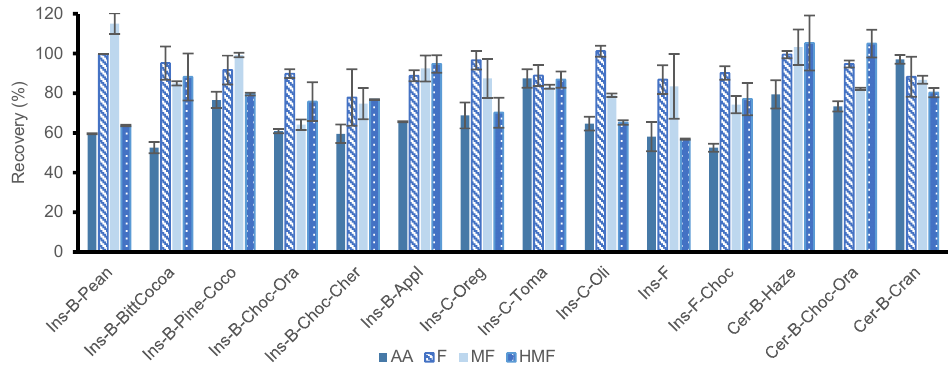
Figure 4. Recovery percentage (%) of acrylamide (AA), furfural (F), 5-methylfurfural (MF) and hydroxy-methyl-furfural (HMF) obtained in the study with samples doped at high level (50 µg/g) with optimized conditions of SLE-SPE procedure.